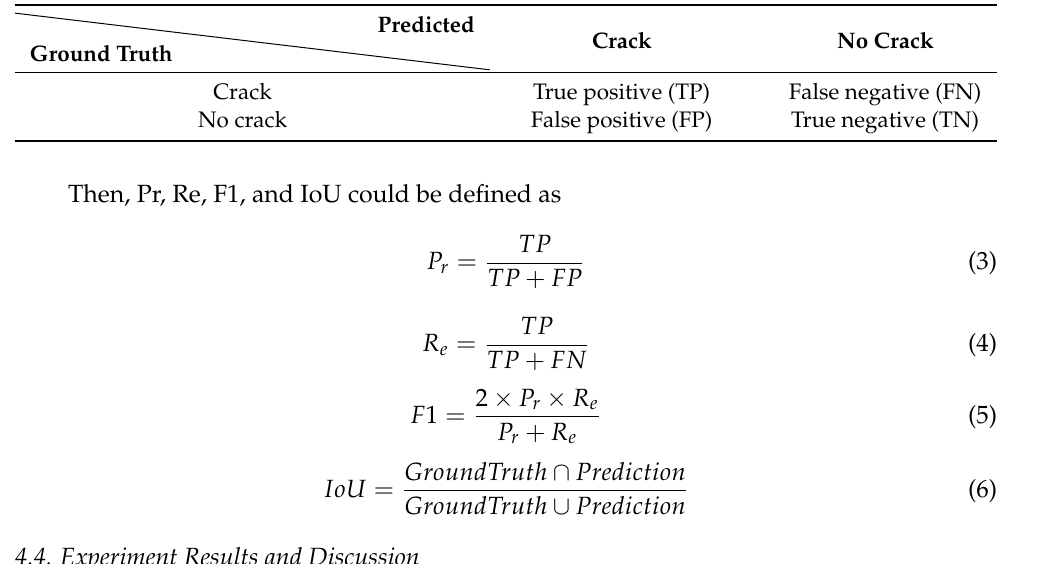
Table 1. All the results of the predicted case and the ground truth case.